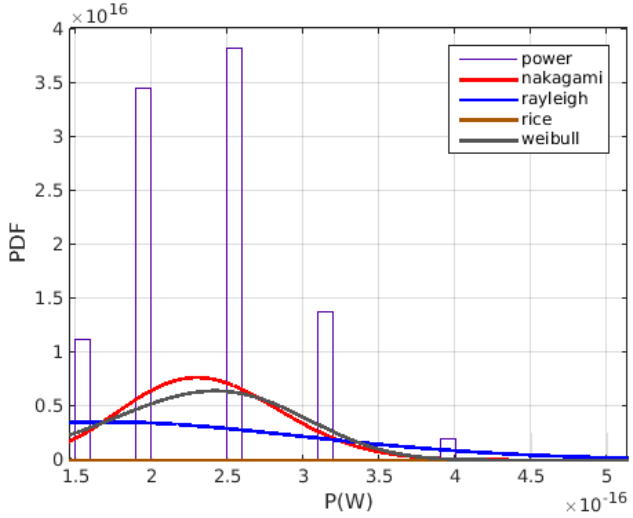
Figure 4. PDF of instantaneous power measurements (W) for LoRa SF12 at a distance of 250m.